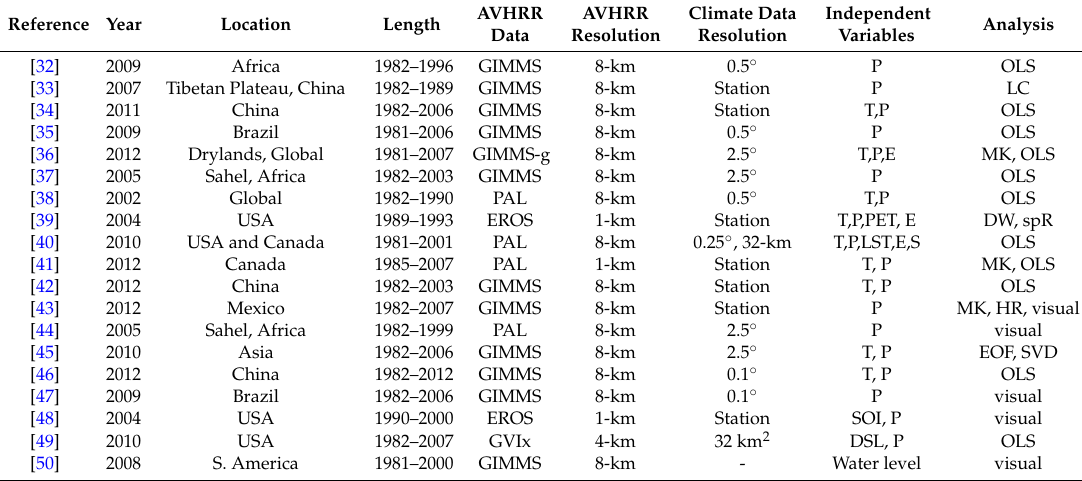
Table 1. Recent studies of AVHRR NDVI—climate data